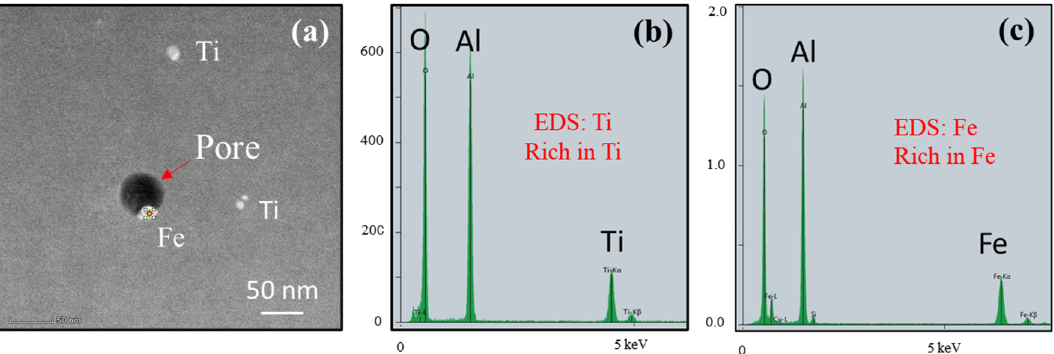
Figure 13. ( a ) Al 2 O 3 TGO triple point region marked O in Figure 11, showing fine ~25 nm Ti- and Fe-rich particles. EDS spectra of Ti ( b ) and Fe ( c ) particles.